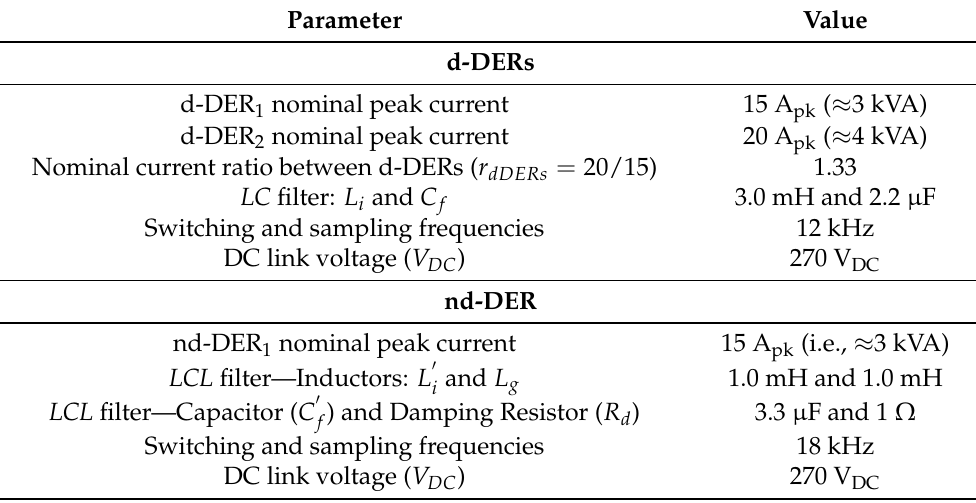
Table 2. Parameters of DERs in the single-phase MG prototype used for experiments.